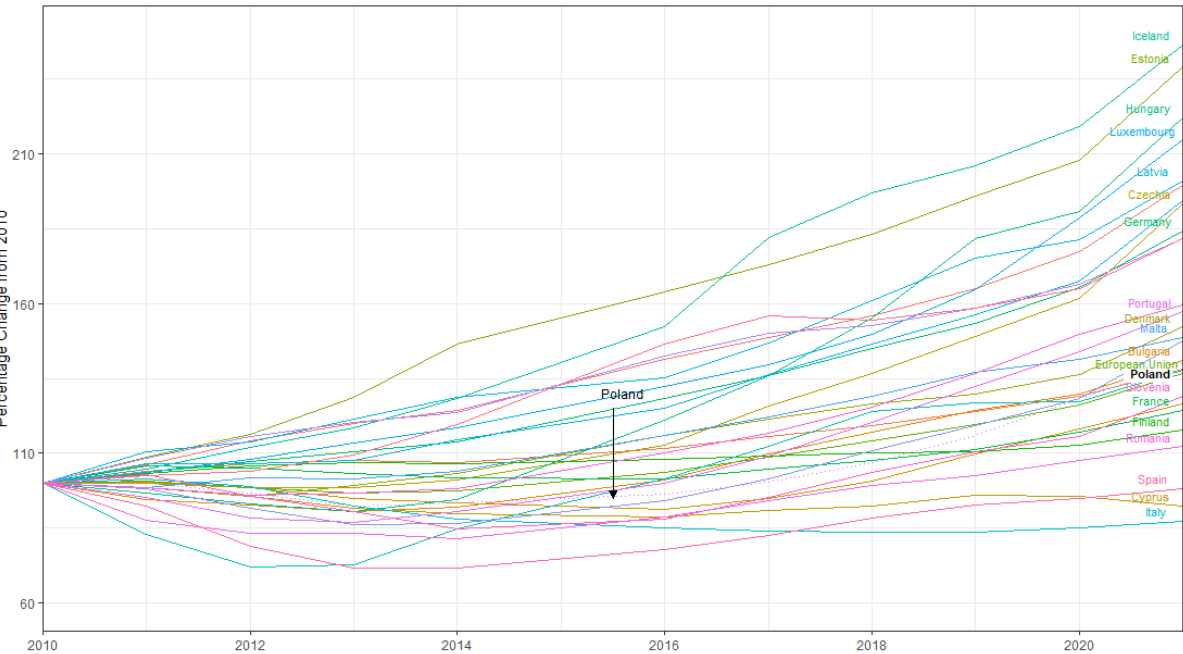
Figure 2. Change in average apartment/house prices over the period 2010–2021 in various European countries (percentage change from 2010, source: own elaboration based on Eurostat—https://ec.europa.eu/eurostat/cache/digpub/housing/bloc-2a.html?lang=en (accessed on 23 March 2023)).